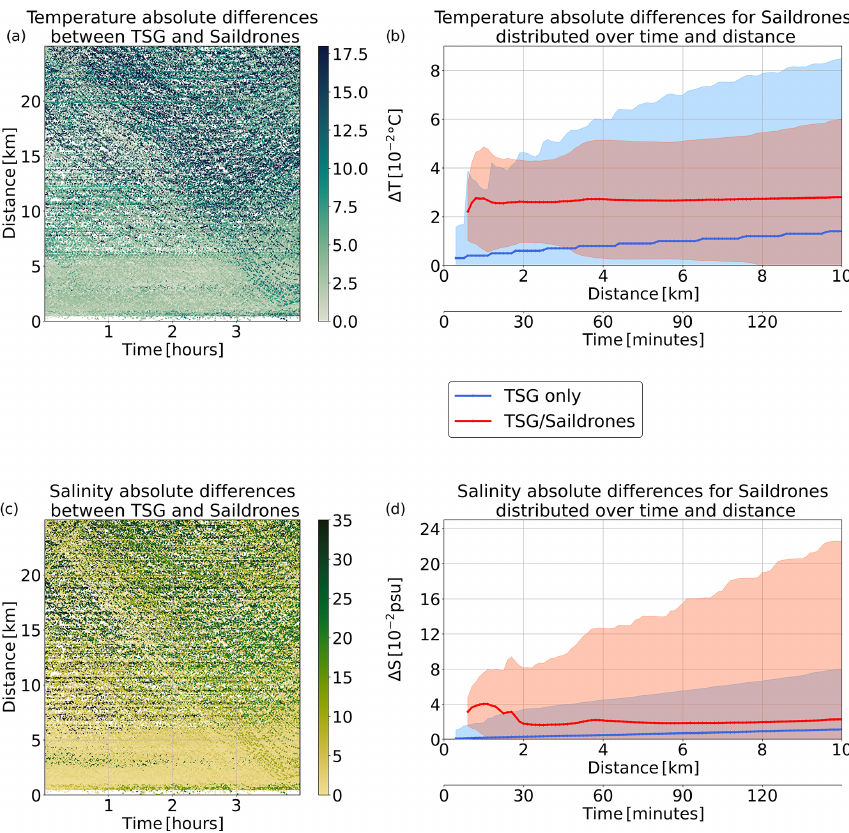
Figure 17. (a) Absolute temperature differences between TSG/Saildrone pairs of measurements distributed in time and distance. Each pair is composed of one R/V’s TSG measurement and a Saildrone one. (b) Temperature differences as a function of time and distance for a pair of surface measurements. Differences are given in blue for pairs of R/V TSG-only profiles and in red for pairs composed of one R/V TSG and one Saildrone. Panels (c) and (d) are same as above but for absolute salinity differences.